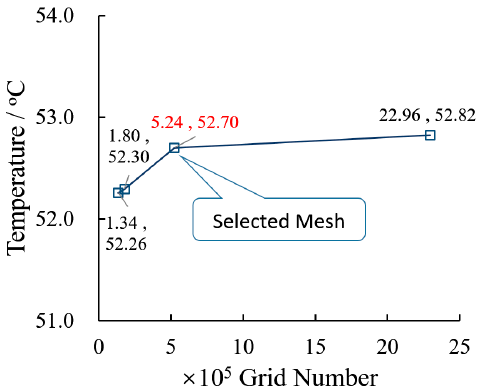
Figure 3. The maximum temperature on the side under different grid